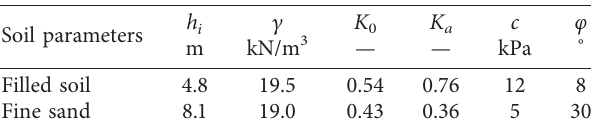
Figure 3: Sketch and the simplified load distribution of the river embankment (unit: m). Table 1: Soil parameters. Table 2: Computation of slurry pressure (unit: